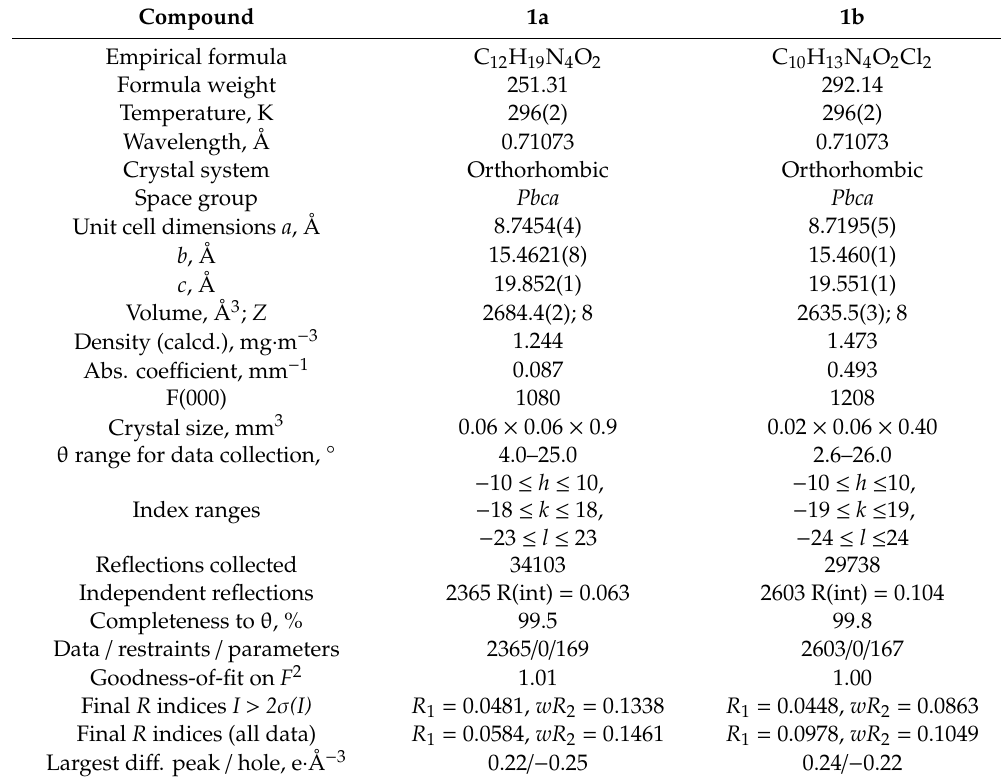
Table 1. X-ray di ff raction data for nitronyl nitroxides 1a,b .